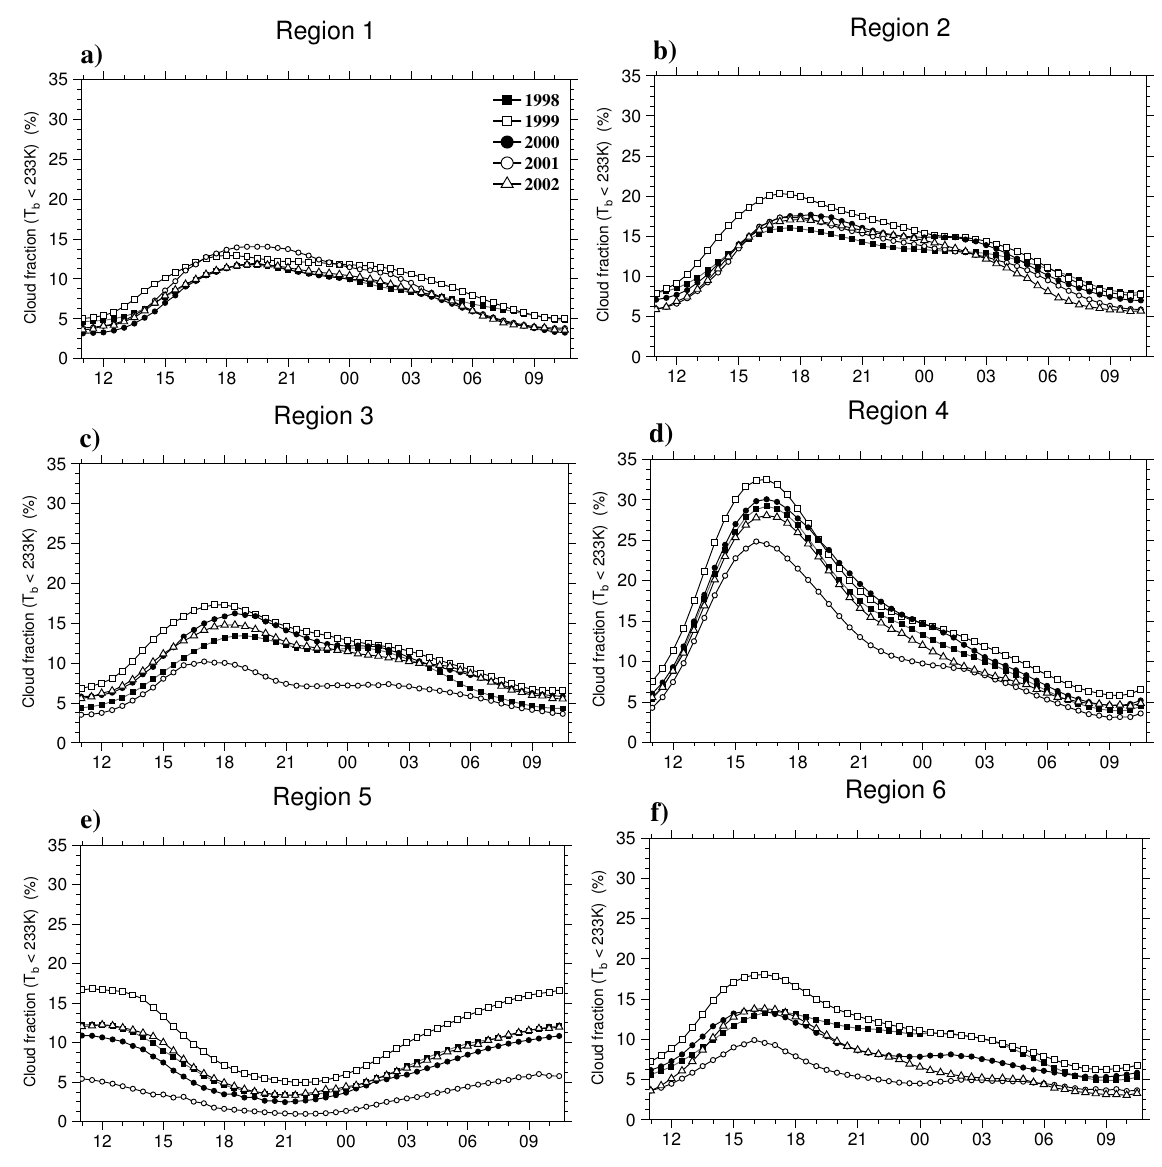
Figure 8. Year-to-year regional variation of the averaged cloud fraction at 233 K. Curve for each year is defined by corresponding symbol. The horizontal axis correspond to the local solar